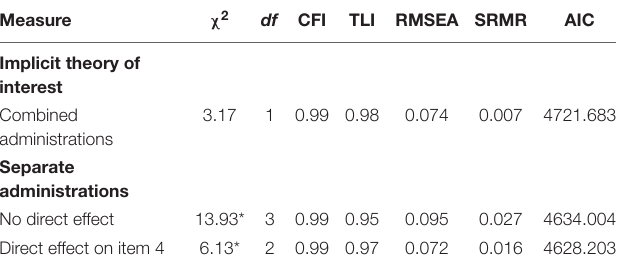
TABLE 6 | Fit indices for MIMIC model on original four items identifying non-invariance for item four.